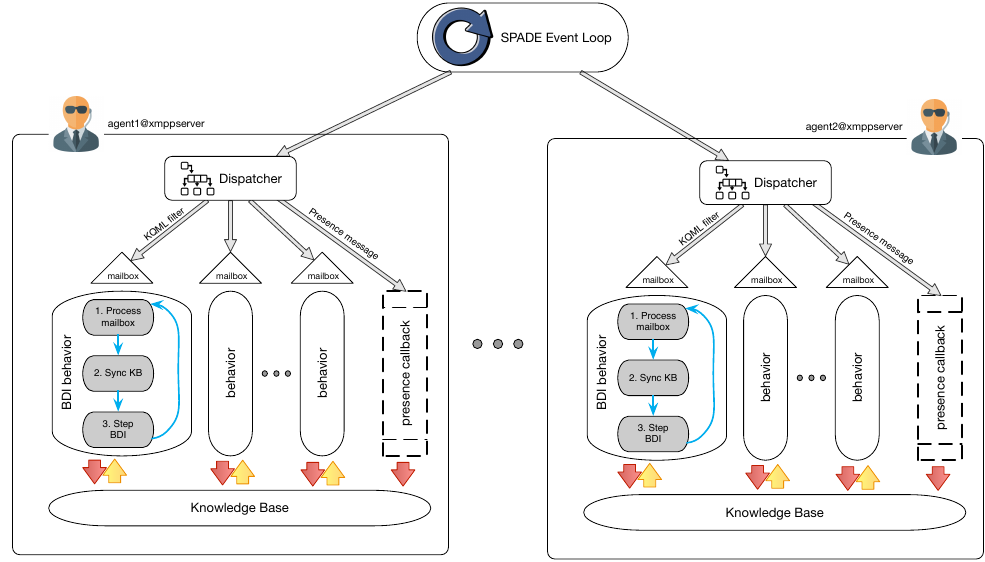
Figure 2. Flexible Agent Architecture in SPADE